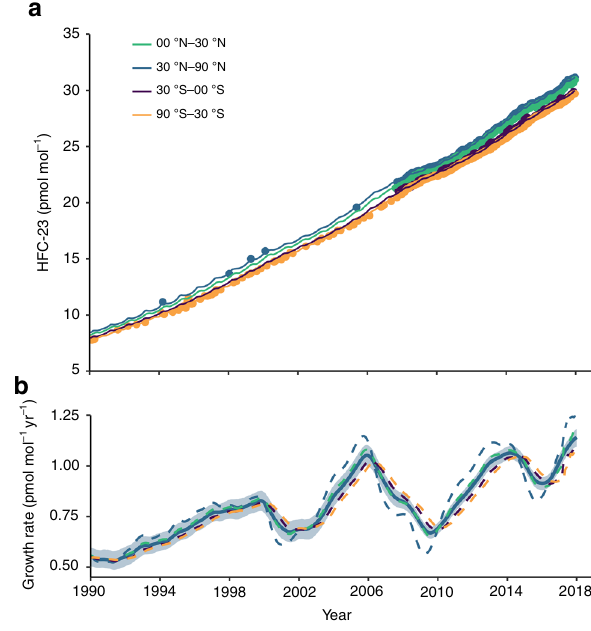
Fig. 2 HFC-23 observations, model-derived mole fractions and growth rates. a Modelled atmospheric HFC-23 mole fractions in pmol mol (cid:1) 1 for the four equal-mass latitudinal subdivisions in the 12-box model based on in situ measurements at the core background measurement sites (points), northern hemispheric fl ask samples (blue circles; only shown prior to 2007) and Cape Grim Air Archive data (orange circle, only shown prior to 2007). b Model- derived annual HFC-23 growth rates (global - blue solid line with 1-sigma uncertainty indicated by shading; dashed lines show